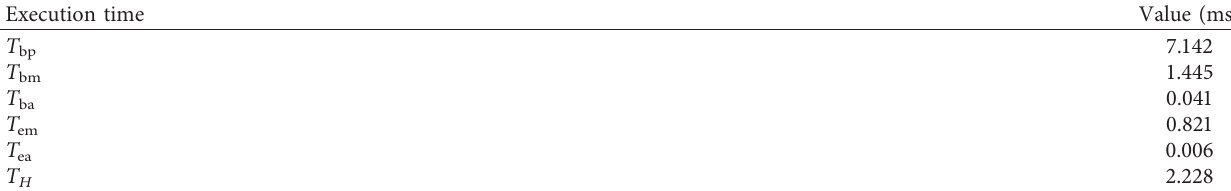
Table 3: Execution time of cryptographic operations.